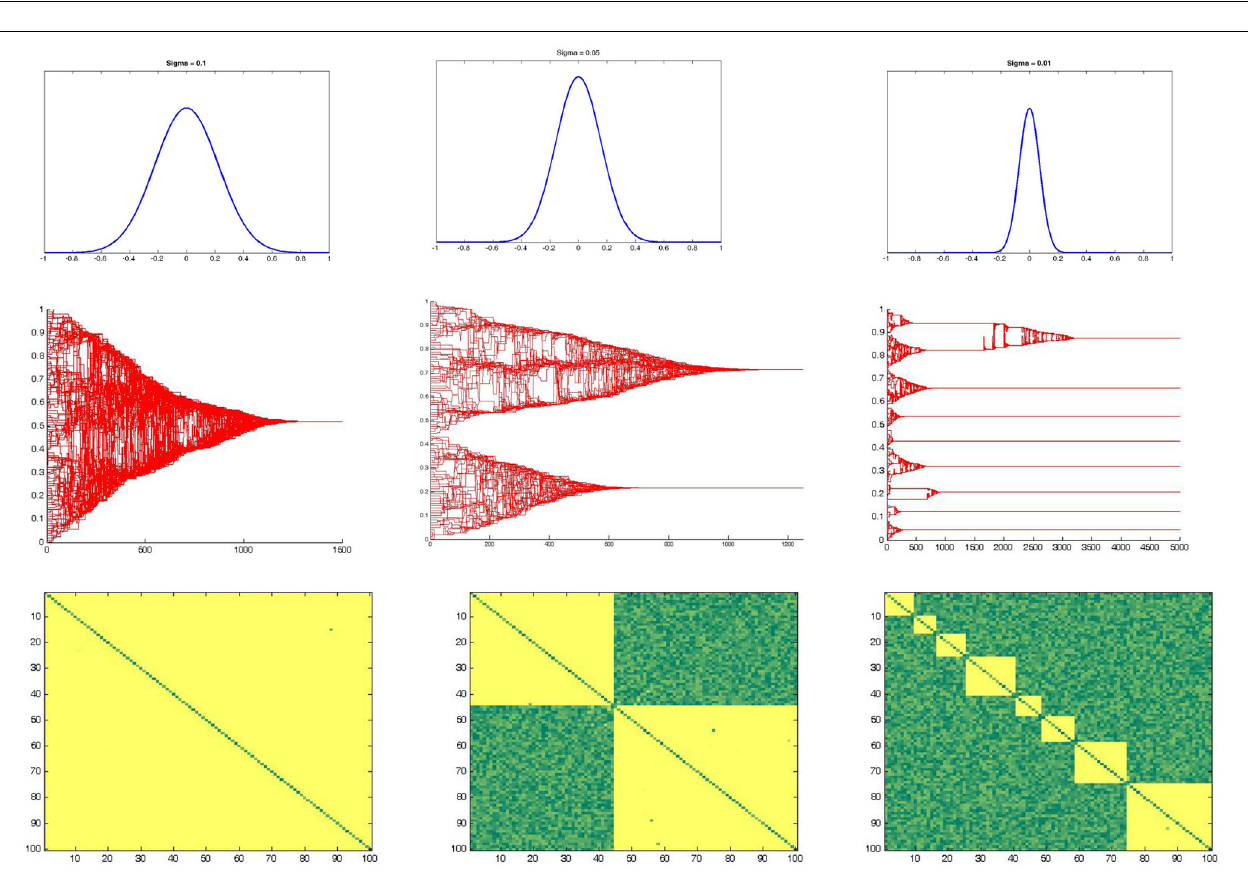
dimension of such trajectories. On the right the distribution along three decades of the opinion jumps of the agents (i.e., the movements along the opinion space realized by the agents during the entire simulation) is reported using a logarithmic rescaling. The linearity of the interpolating function suggest a power law function controlling such a process.